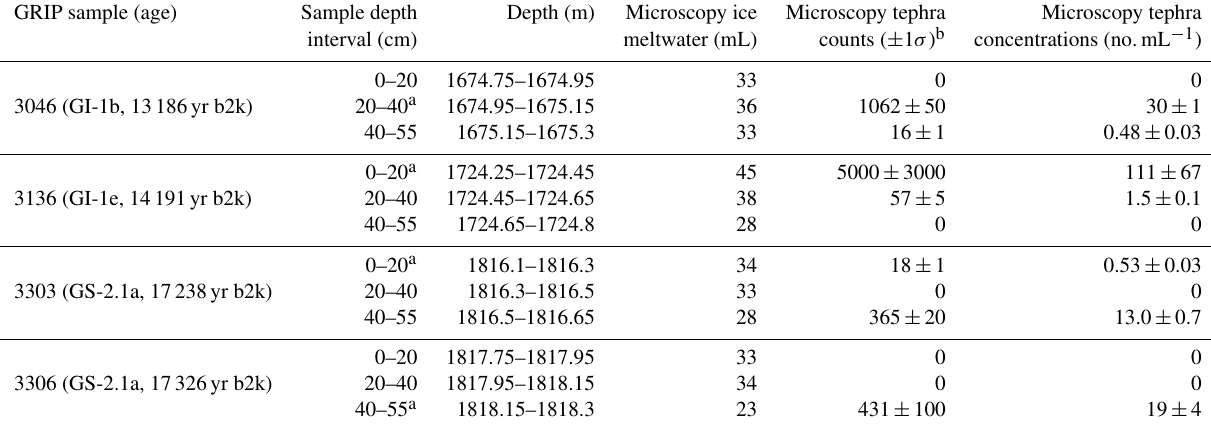
Table 4. GRIP sample details and tephra counts by manual optical microscopy. The sample ages are derived from the GICC05 chronology. Note that b2k means before the year 2000. Bølling–Allerød/Greenland Interstadial 1 is GI-1 and Glacial/Greenland Stadial 2 is GS-2. GRIP sample